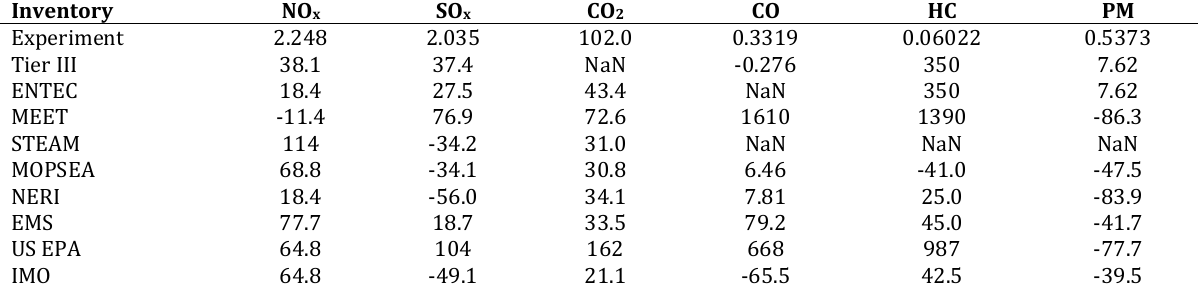
Table 4: Inventory deviations from the experimentally measured total emission amounts in % for the main engine at berth. The experimental measurements are given in the second row in kg per time equal to the experiment duration according to the third column of Table